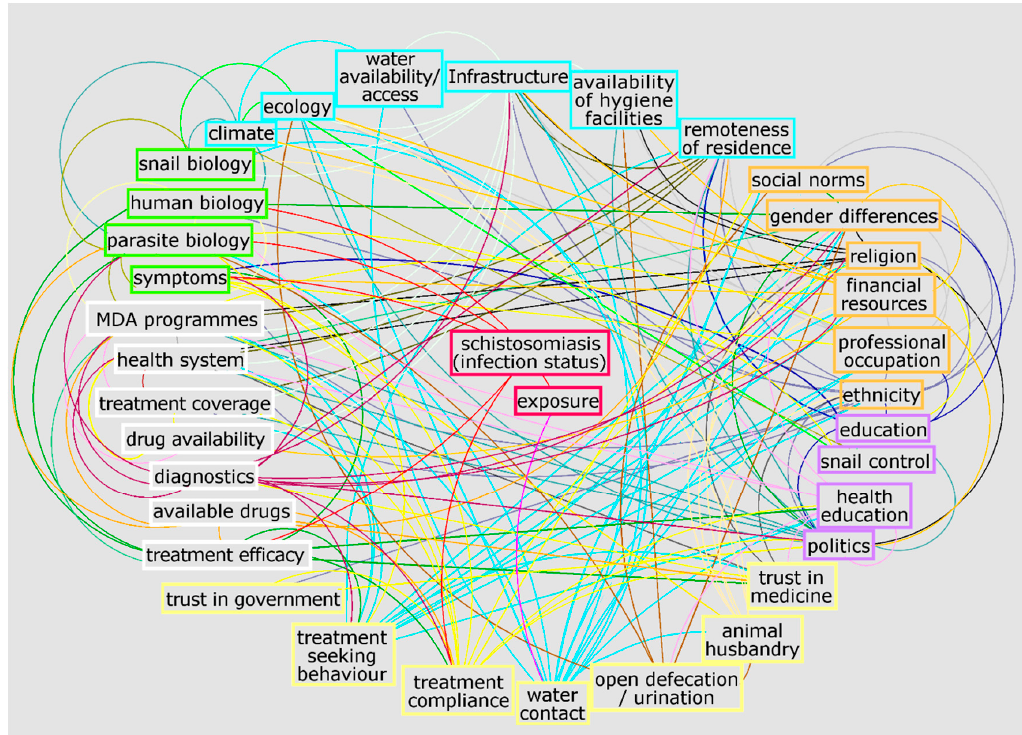
Figure 1. Potential network of factors influencing schistosomiasis infection and disease created with Vensim [59] and GIMP [60]. Connections are a collection of empirically tested or hypothesised relationships. Colours are for illustrative purposes only. This diagram resulted from ongoing brainstorming of connections from a large body of literature and expert knowledge. The diagram aims to exemplify the complexity of the schistosomiasis system without claims of completeness and without detailing the exact nature and direction of interactions. It is meant solely for the purpose of an example of what a systems diagram for schistosomiasis could provide. The full diagram(s) would need to be developed through extensive empirical and theoretical research.